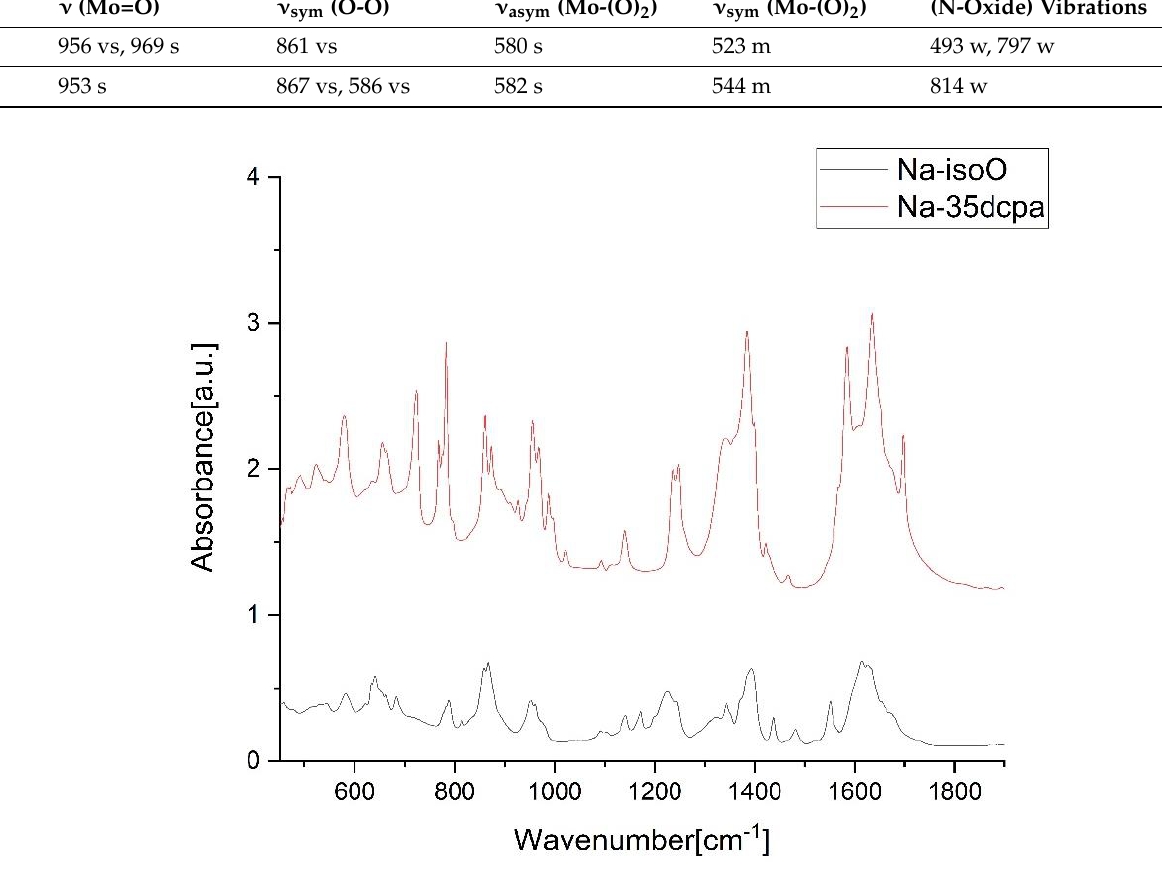
Figure 3. IR spectra of the compounds Na-35dcpa and Na-isoO . All range (400-4,000 1/cm) wave- number is presented in Figure S2. Table 2. IR spectra vibrations and band assignments connected with oxodiperoxido- molybdate